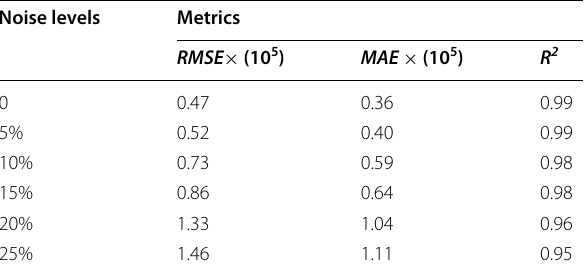
Table 2 Prediction performance of crowd forces at different noise levels